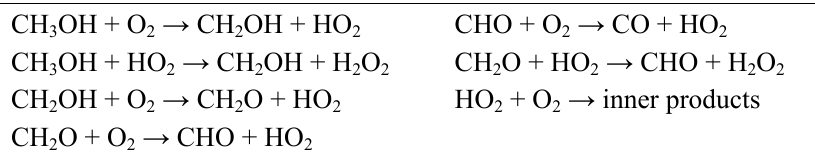
Table 9. Methanol combustion mechanisms proposed by Bell and Tipper